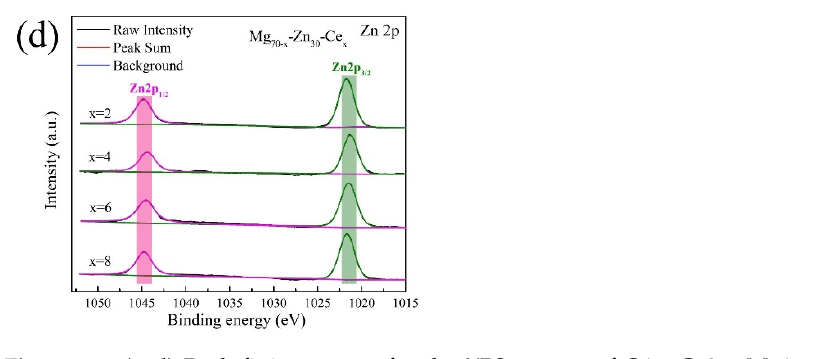
Figure 11. ( a – d ) Peak fitting curves for the XPS spectra of O1s, Ca2p, Mg1s, and Zn2p in the Mg 70 − x Zn 30 Ce x (x = 2, 4, 6, and 8) amorphous alloys, respectively. As shown in Figure 12, multiple Ce3d peaks were observed. The characteristic peaks marked with u and v belonged to the 3d3/2 and 3d5/2 orbitals of Ce. The characteristic peaks of Ce 4+ correlated to u 0 , u 1 , u 3 , v 0 , v 1 , v 2 , and v 4 , while the characteristic peaks of Ce 3+ correlated to u 2 , u 4 , v 3, and v 5 [43].Ce is relatively active; therefore, it likely preferentially reacted with dissolved oxygen in the simulated body fluid. Thus, Ce 4+ was present in the form of CeO 2 , whereas Ce 3+ was likely in the form of Ce 2 O 3 . The solubility product constants of the phosphates followed the order: Ca 3 (PO 4 ) 2 (Ksp = 2.07 × 10 − 33 ) < Zn 3 (PO 4 ) 2 (Ksp = 9.1 × 10 − 33 ) < Mg 3 (PO 4 ) 2 (Ksp = 1.04 × 10 − 24 ) < CePO 4 (Ksp = 7.43 × 10 − 11 ) [42]. Calcium phosphate always remained in the final corrosion products, regardless of whether a Mg-based or Zn-based matrix was used, and zinc phosphate or magnesium phosphate converted to calcium phosphate based on the change in precipitation–dissolution equilibrium.